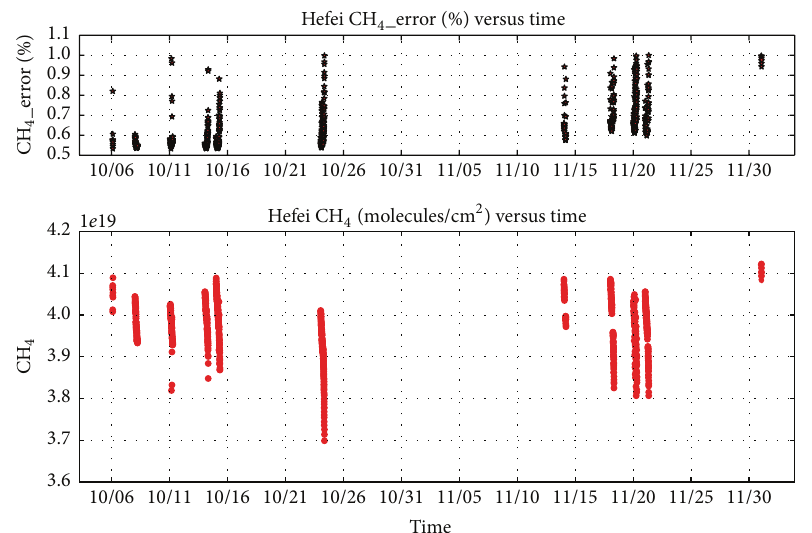
Figure 6: VCD time series ranging from October 6, 2014, to December 1, 2014, which are the average of the retrieval values in 5938 cm −1 , CH 4 6002 cm −1 , and 6076 cm −1 windows.